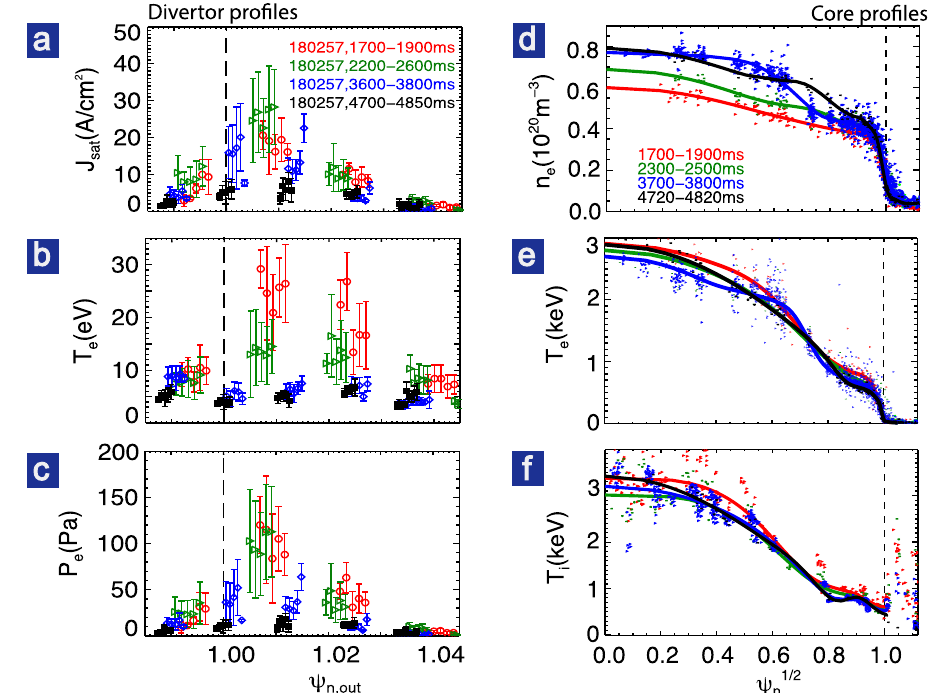
Fig. 2 Divertor pro fi les (left) and core plasma pro fi les (right) for attached divertor (red), high-recycling divertor (green), pronounced detachment (blue) and full detachment (black). a – c Divertor particle fl ux, electron temperature, and electron pressure with statistical error bars also shown. d – f Core electron density, electron temperature, and ion temperature. Electron density and temperature are measured by the Thomson Scattering system. Ion temperature is measured by charge – exchange recombination system for C6 + impurity ions. The EFIT strike point in ( a – c ) was shifted by 0.5% ψ n to match